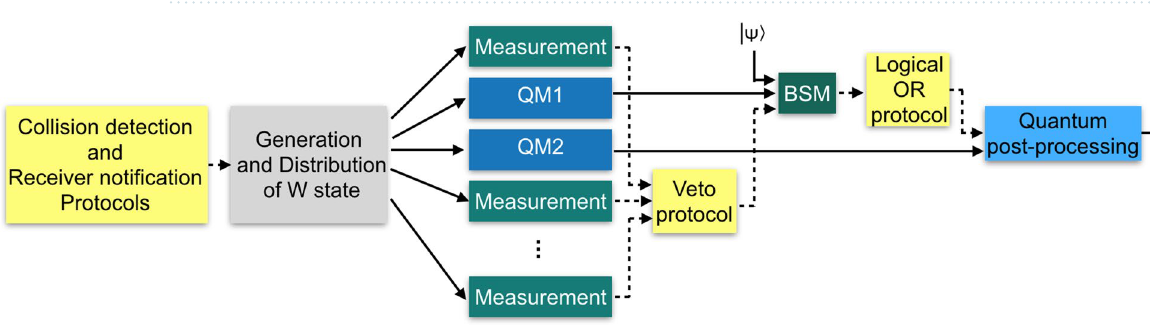
Figure 3. General description of W-state based anonymous transmission protocol. Solid arrows represent quantum communication, while dotted arrows represent classical communication. QM quantum memory, BSM Bell state